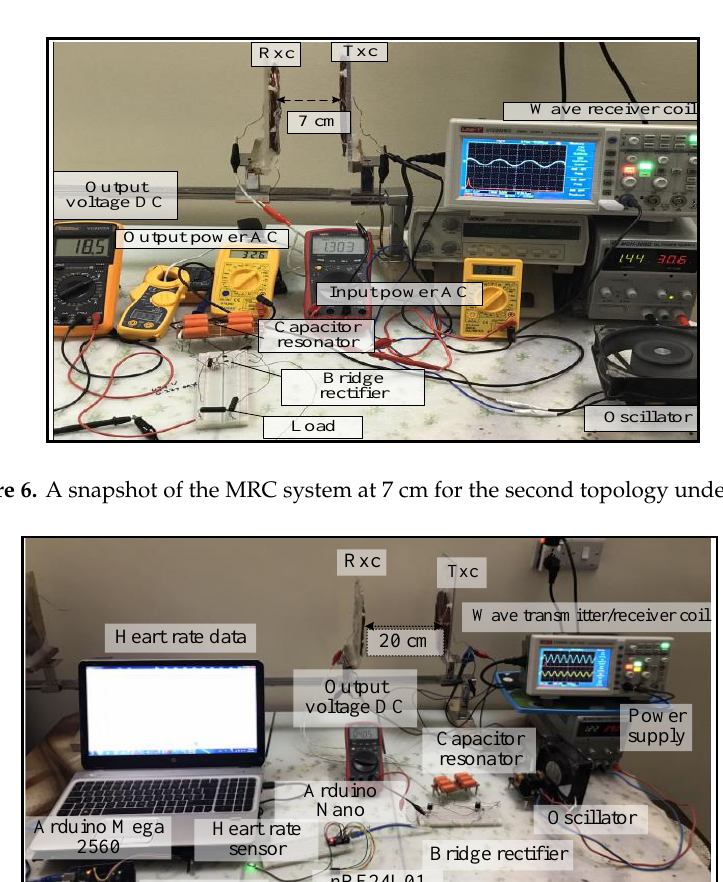
Figure 5. A snapshot of the MRC system at 9 cm for first topology for real time.